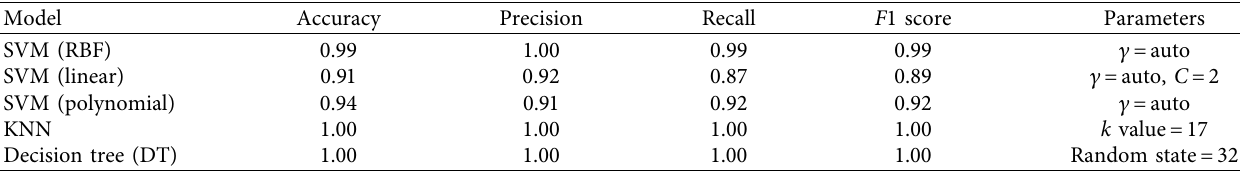
Table 12: Openness to experience classifcation report.